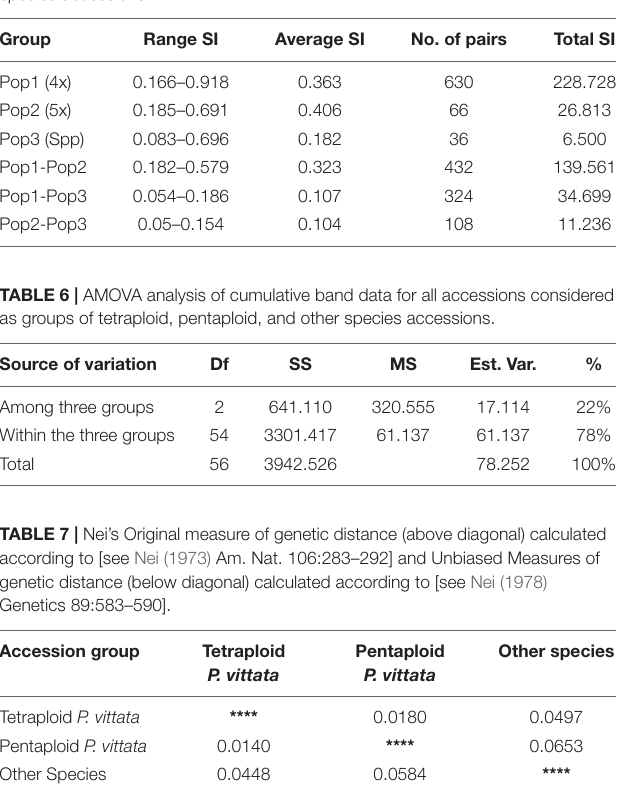
TABLE 5 | Analysis of “population” similarity coefficients for the cumulative band data for all accessions considered as groups of tetraploid, pentaploid, and other species accessions.